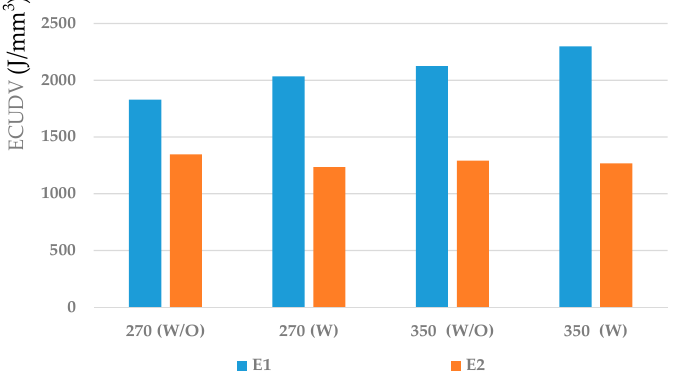
Figure 8. Effect of ultrasonic vibration on energy consumption ( E 1 : theoretical value, E 2 : actual value, powder: Inconel 718, scanning speed: 8.47 mm/s, powder feed rate: 2.5 rpm).